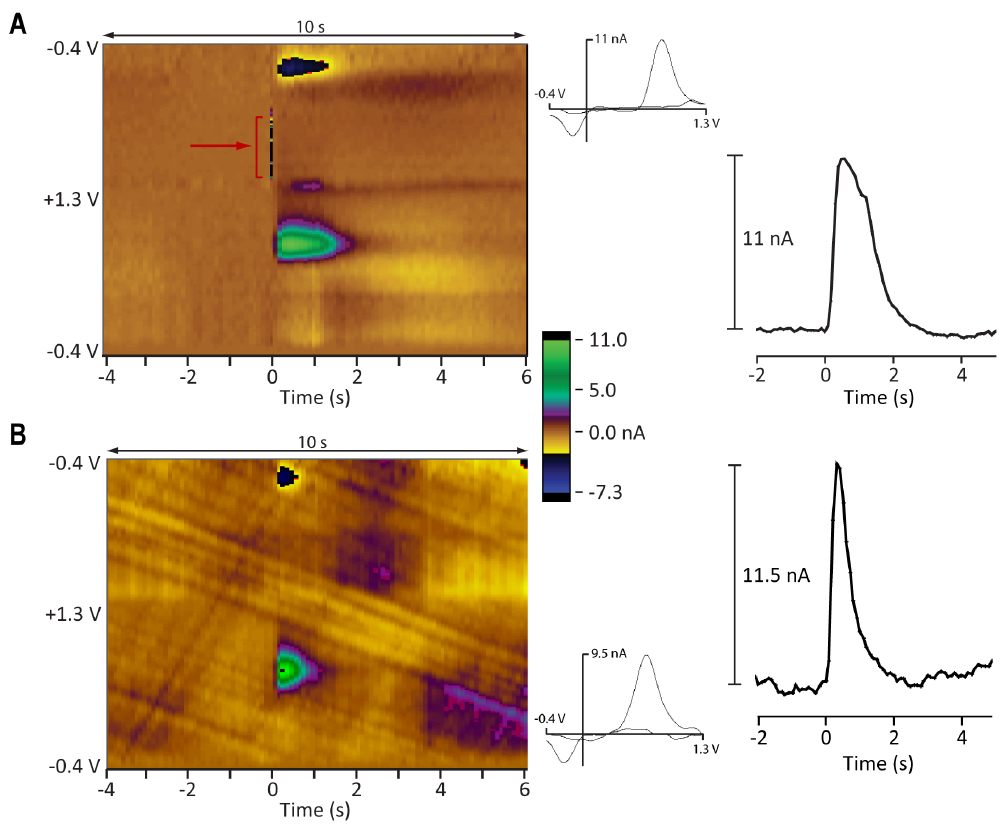
Figure 5. VTA/SNc stimulation-evoked response in two subjects. VTA/SNc stimulation-evoked dopamine response recorded from the ventral striatum of two monkeys. (A) Monkey N. Stimulation parameters: 400 m A, 120 PPS, 1 s train. Left: background subtracted color plot corresponding to the pair of sites designated 2N in Fig. 2 and Table 1. DA release follows rapidly after stimulation at time 0. The red arrow and bracket point to the intentional stimulation artifact that marks onset of stimulation. Right: Small inset graph shows the voltammogram at maximum DA release. Larger plot shows the current response at peak oxidation potential. (B) Monkey B. Stimulation parameters: 200 m A, 120 PPS, 2 s train. Left: background subtracted color plot corresponding to the pair of sites 1B in Fig.2 and Table 1. DA release following stimulation at time 0. Right: Same plots as in A. Vertical color bar shows pseudocolor calibration for both color plots.